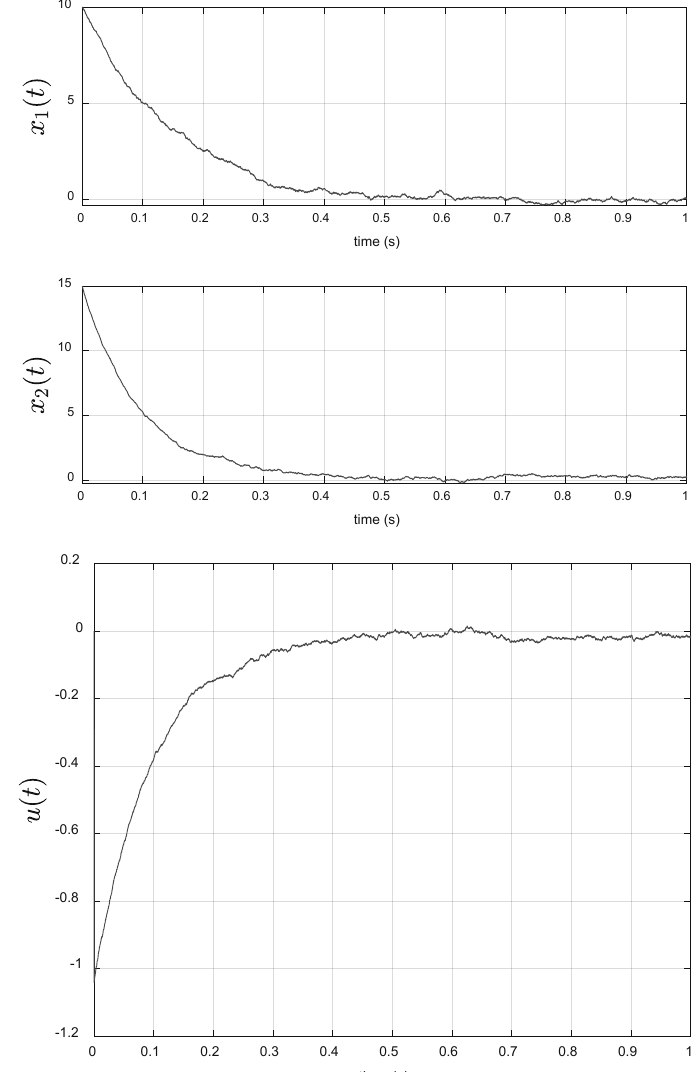
Figure 2. Asymptotic behavior of the state of dynamic system ( top ) and optimal control α -discount LQR ( bottom